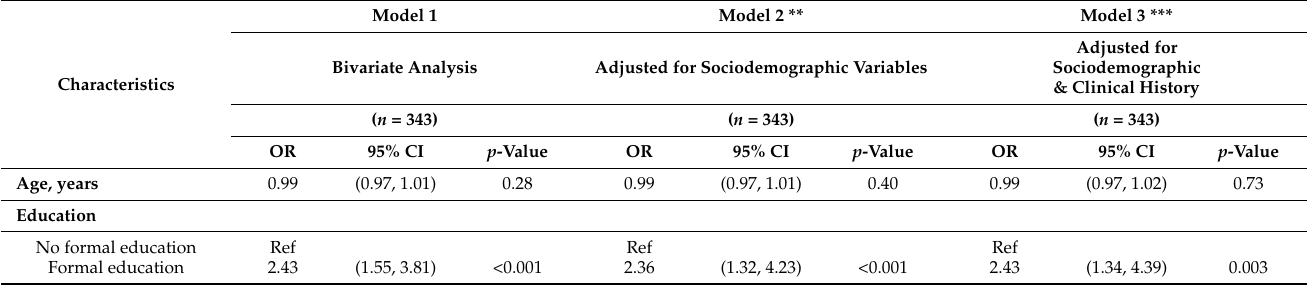
Table 3. Factors associated with medication adherence 1 among 343 diabetes patients at Dhulikhel hospital